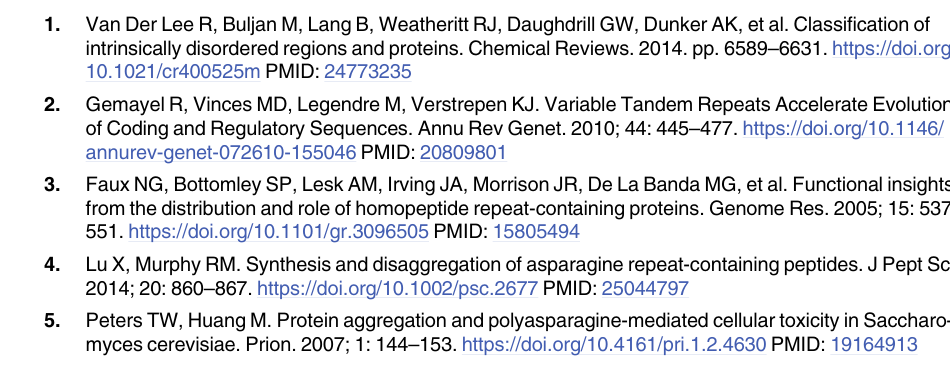
S4 Table. Fold change in AZF1 expression in 3 biological replicates of azf1 Δ compared to WT. (PDF) S5 Table. Differentially expressed genes in azf1 Δ compared to WT during growth in glu- cose. (CSV) S6 Table. Differentially expressed genes in Δ N compared to WT during growth in glucose. (CSV) S7 Table. Differentially expressed genes in Δ N compared to WT during growth in glycerol.